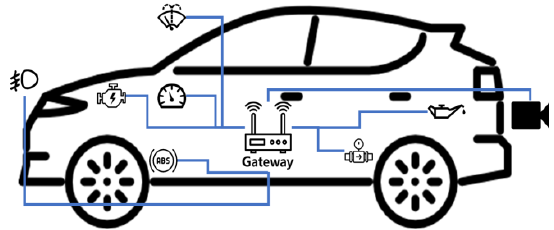
Figure 1. Vehicle gateways that need to handle in-vehicle sensor data.